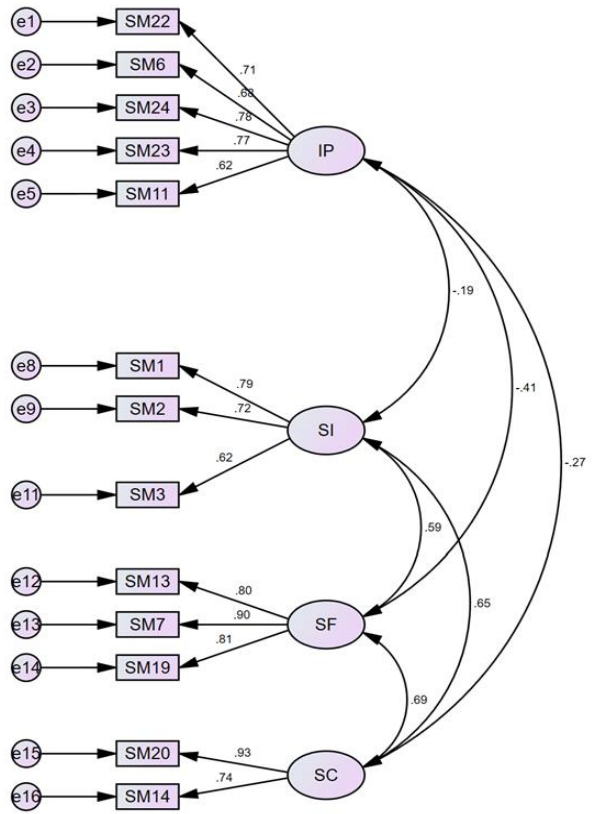
Figure 1. CFA model output from AMOS 22.